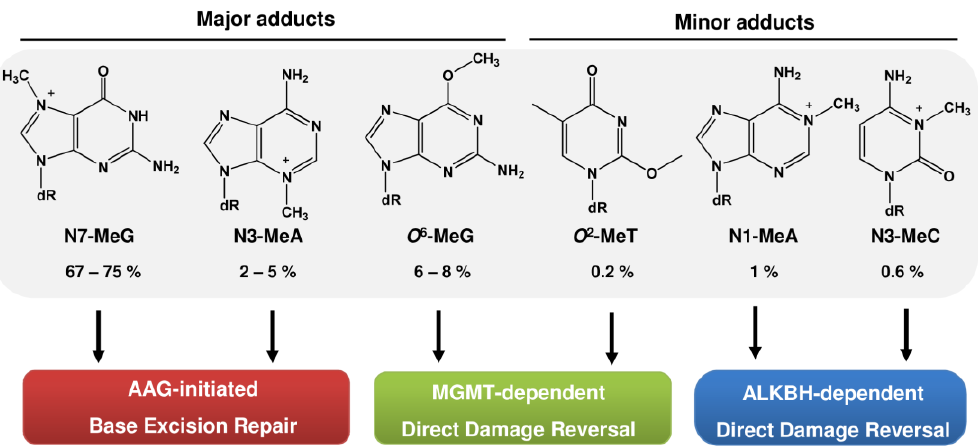
Figure 6. DNA methylation adducts and involved DNA repair pathways. Given is the relative per- centage of the total methylated DNA adducts in rat liver following exposure to NDMA for 2 h [23]. AAG: alkyladenine glycosylase; MGMT: O 6 -methylguanine-DNA methyltransferase; ALKBH: AlkB homolog.